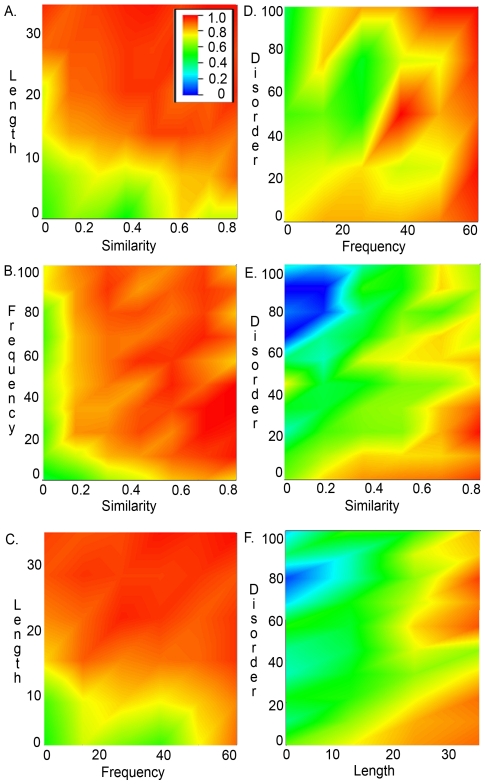
Alignability of blocks depends on various attributes.By combining 8 different MSA programs, a majority of blocks can be well aligned (red regions in the heat maps), but certain blocks remain problematic (blue, green regions). (A) Short blocks (<10 residues) with low similarity (<0.5) are aligned with 40–60% accuracy. (B) The frequency of occurrence in the alignment plays an important role. Blocks that occur in a majority of the sequences, even very divergent ones, are generally well aligned. (C) Short blocks (<10 residues) that occur in a majority of the sequences are also well aligned. (D to F) Blocks in natively disordered regions are generally less well aligned than those in folded regions, and short, divergent blocks are misaligned by all programs (blue regions).